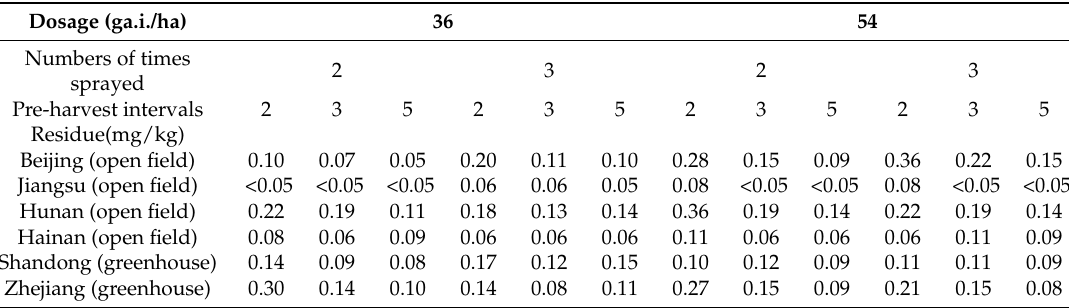
Table 4. Final residues of pyrethrins in leaf lettuce